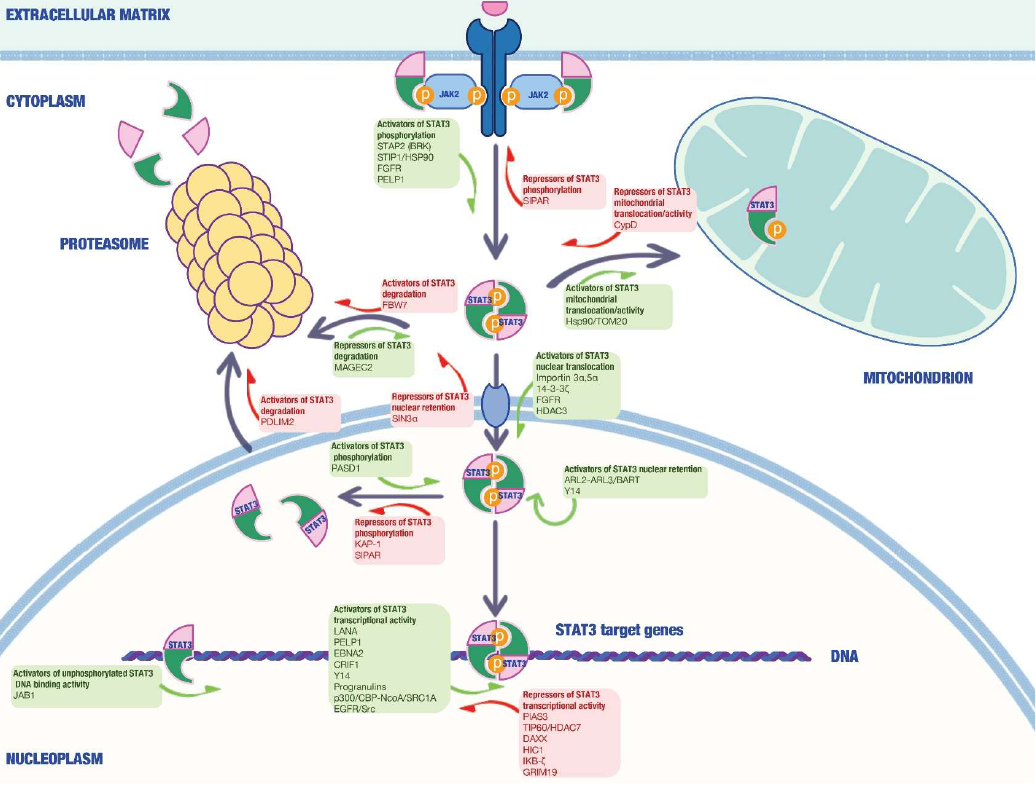
Figure 1. The figure illustrates localization and putative functions of the STAT3-interacting proteins discussed in this review. Green and red boxes enclose STAT3 activators and repressors respectively. Green and red arrows indicate positive and negative regulation of STAT3 expression/activity respectively.